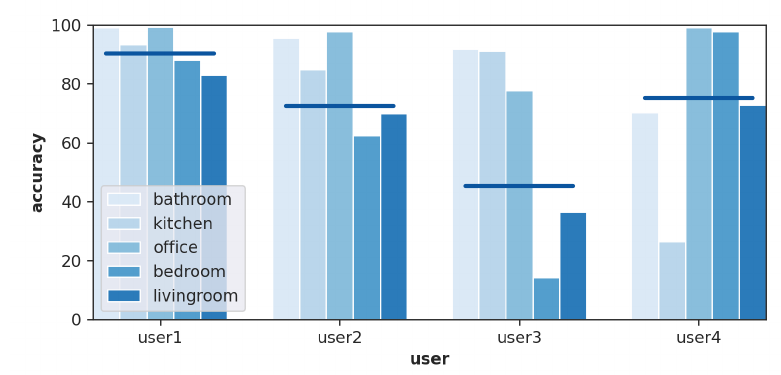
Figure 8. Results of the proximity method. Accuracy is the percentage of times the system is able to correctly estimate the room with respect the ground truth.